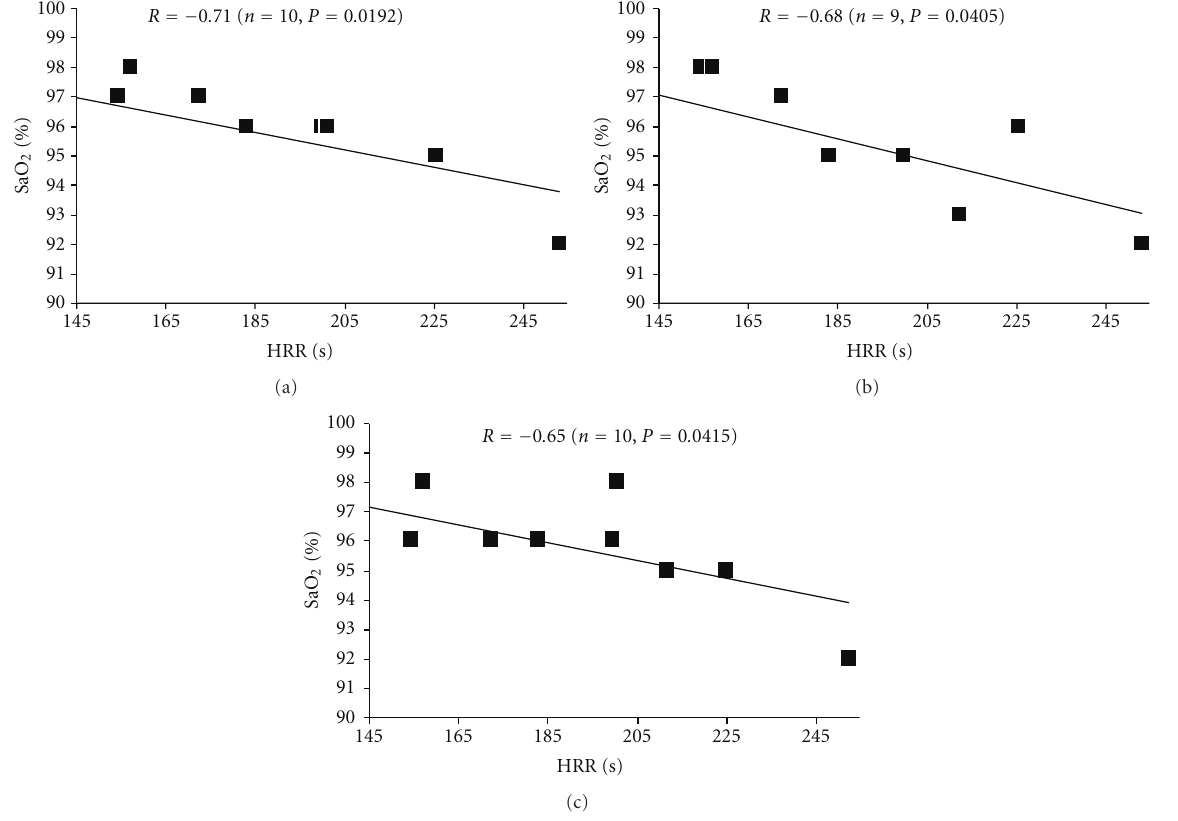
Figure 1: Relationship between heart rate recovery time constant (HRR τ ) and SaO 2 values measured at 1 (a), 4 (b), and 7min (c) recovery after exhausted 400 m